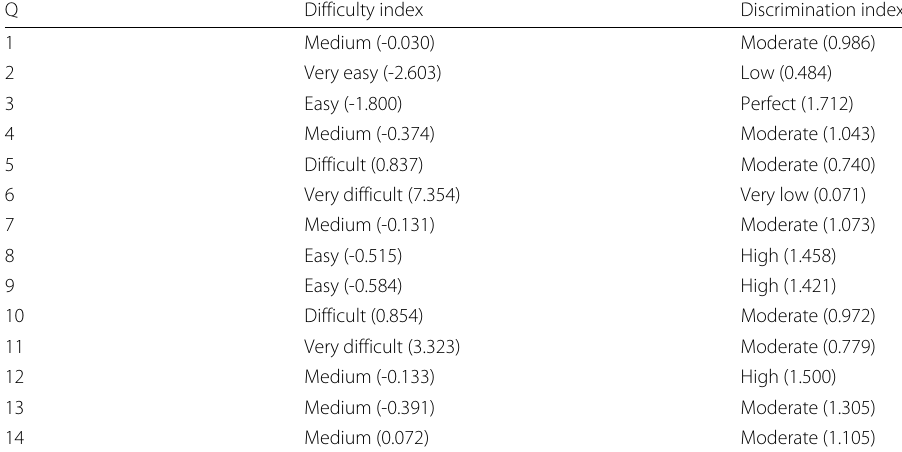
Table 19 Questions’ difficulty and discrimination indices using IRT